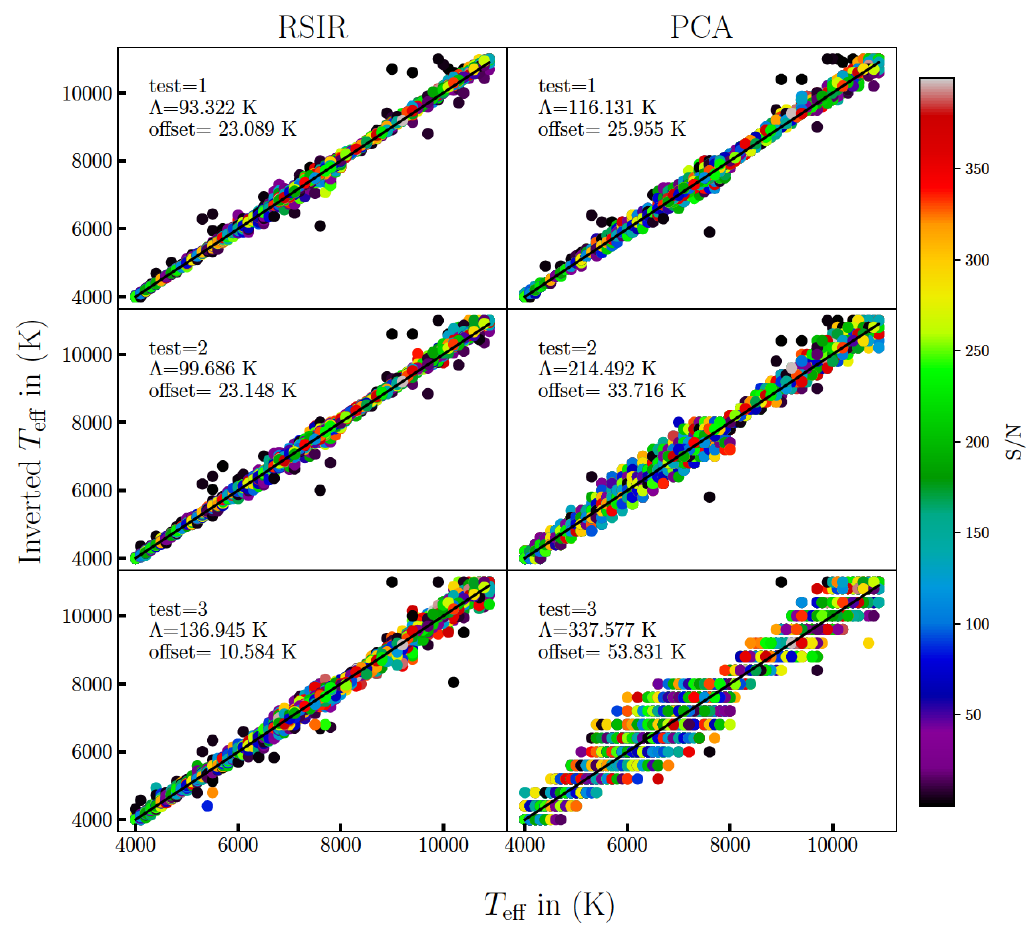
Figure 4. Results of the effective temperature inversion for the synthetic A to K stars. The black line represents the 1-to-1 correspondence. Table 3. Result of inversion using 3 different LDB with different steps on 2500 noisy synthetic FGK